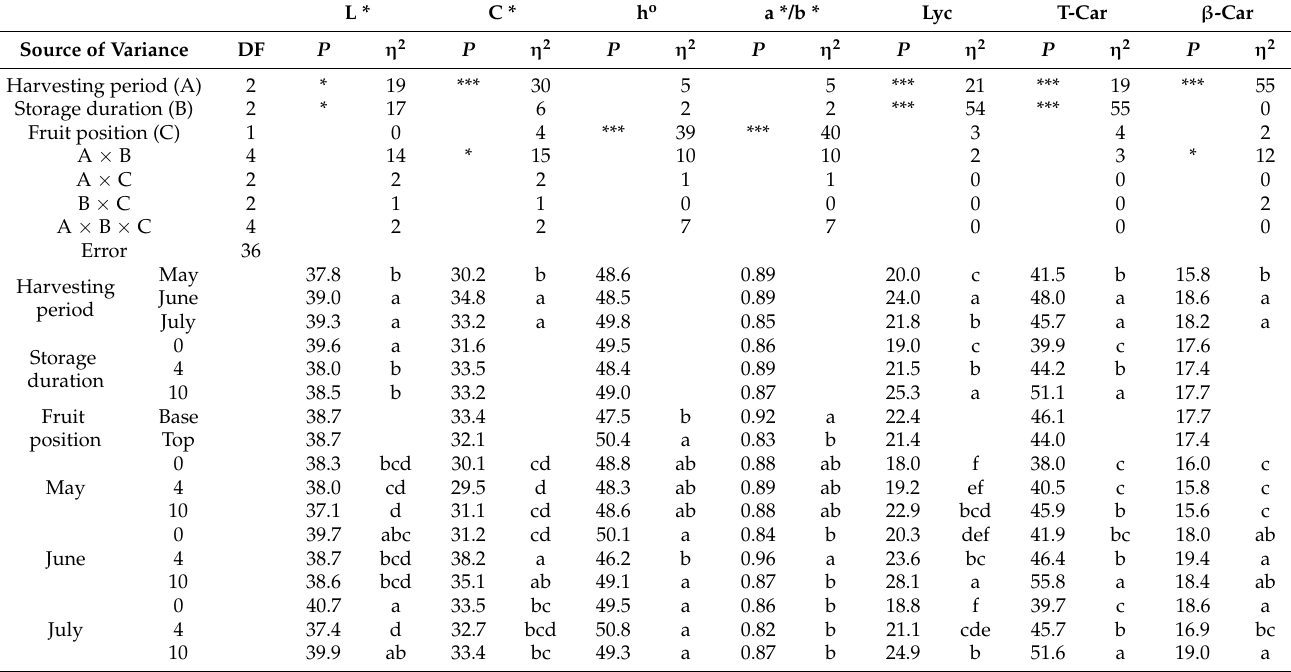
Table 1. ANOVA for color skin parameters lightness (L *), chroma (C *), hue angle (h o ) and a */b * ratio, as well as lycopene (Lyc, µ g/g f.w.), total carotenoids (T-car, µ g/g f.w.) and β -carotene ( β